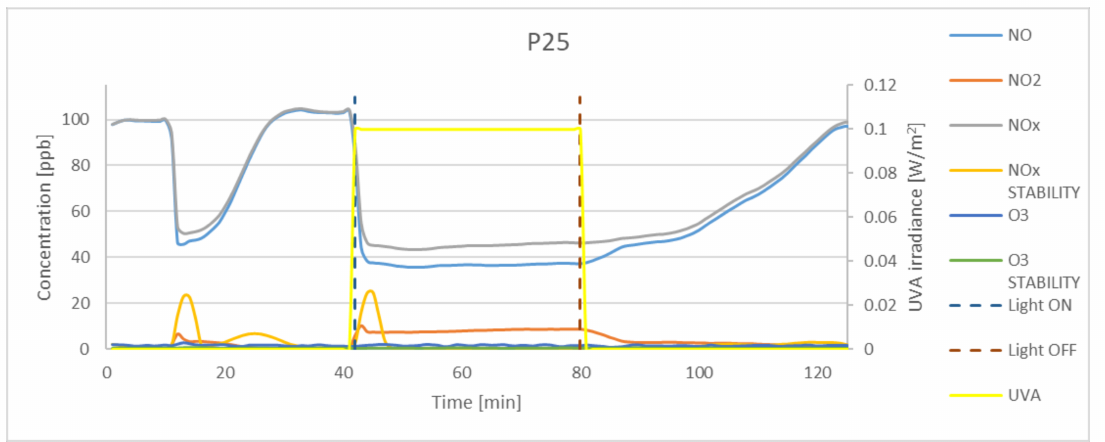
Figure 5. The oxidation of NO in a photocatalytic reaction with concentrations of NO 2 , NO x , and O 3 measured for P25. Data on UVA irradiation are shown in the supplementary chart. Dashed lines indicate the time of light on and off.